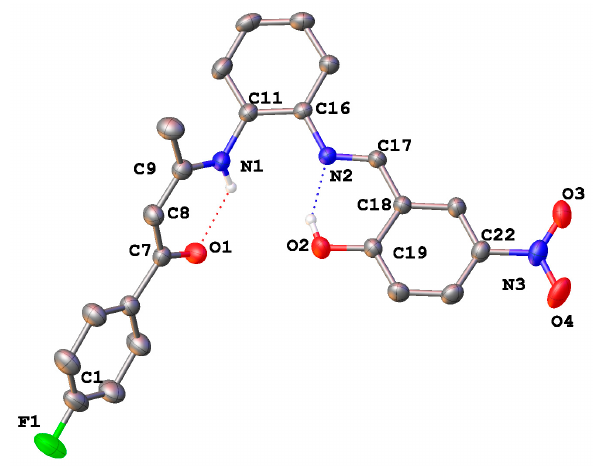
Figure 1. Molecular structure of the Schiff-base proligand 2 showing partial atom numbering scheme. Nonrelevant hydrogen atoms are omitted for clarity. Thermal ellipsoids are drawn at 50% probability.